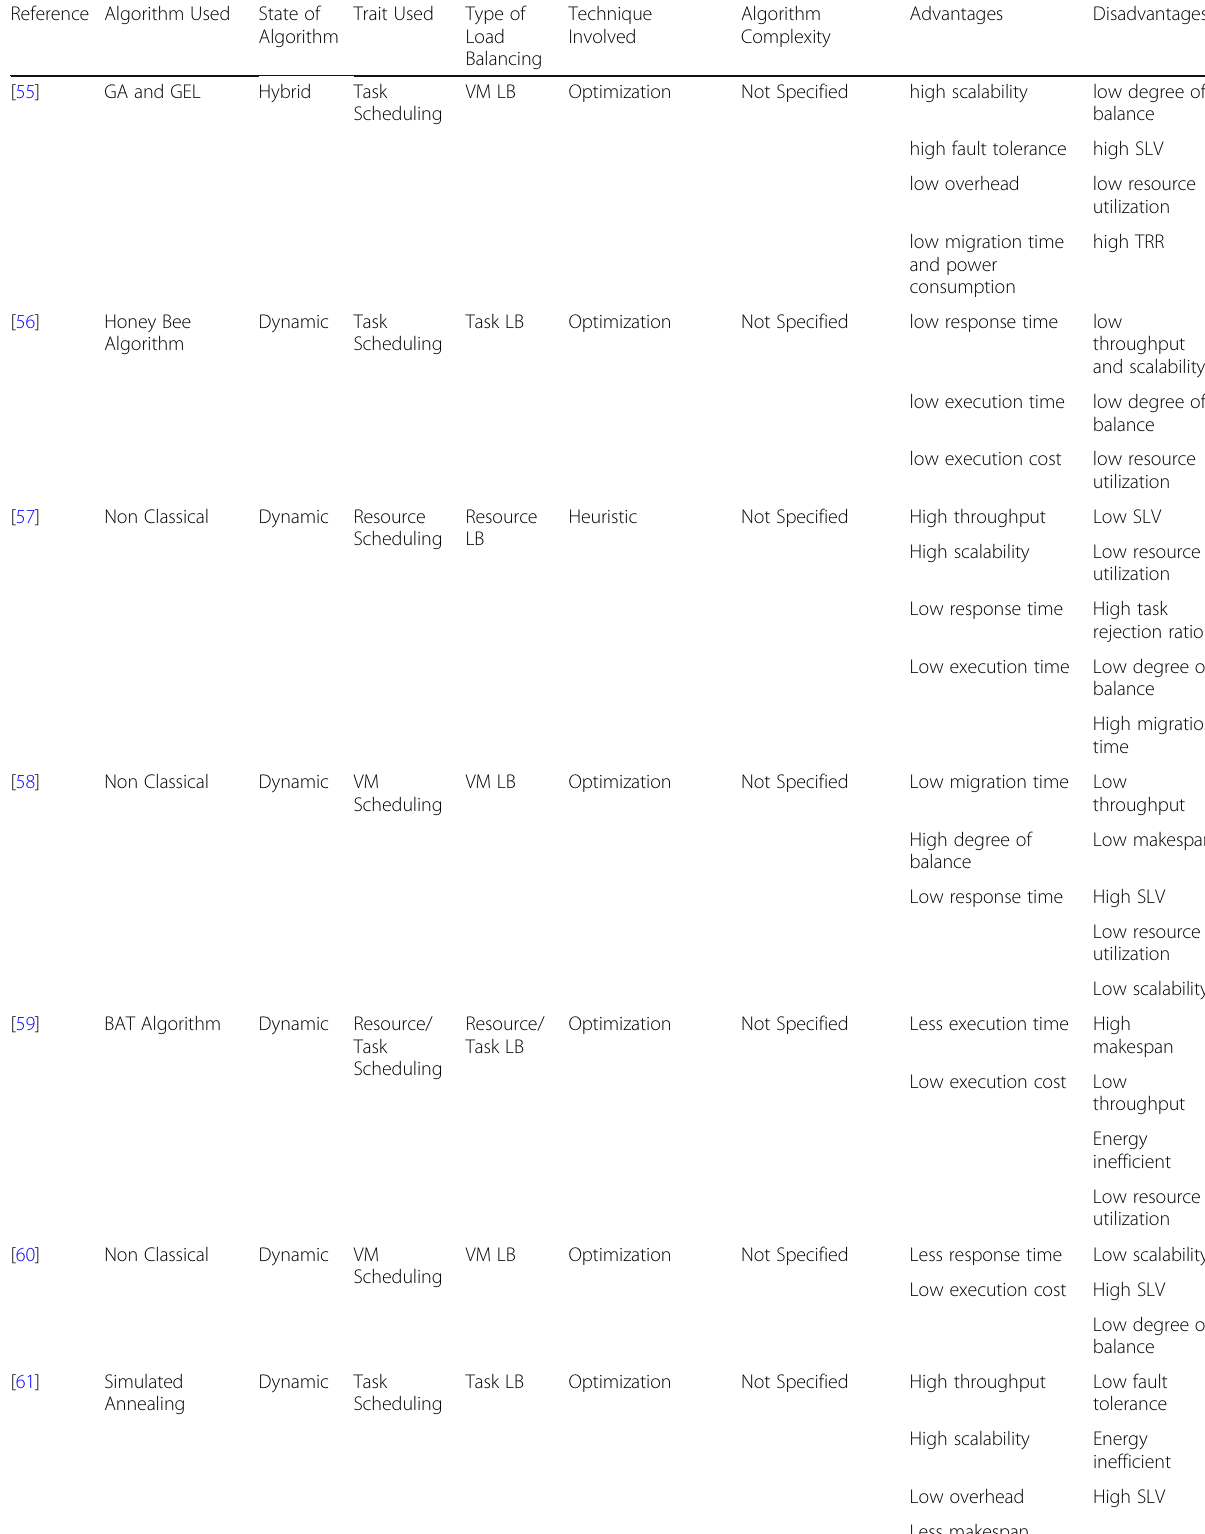
Table 2 Reactive approaches of cloud load balancing in existing literature (Continued) Reference Algorithm